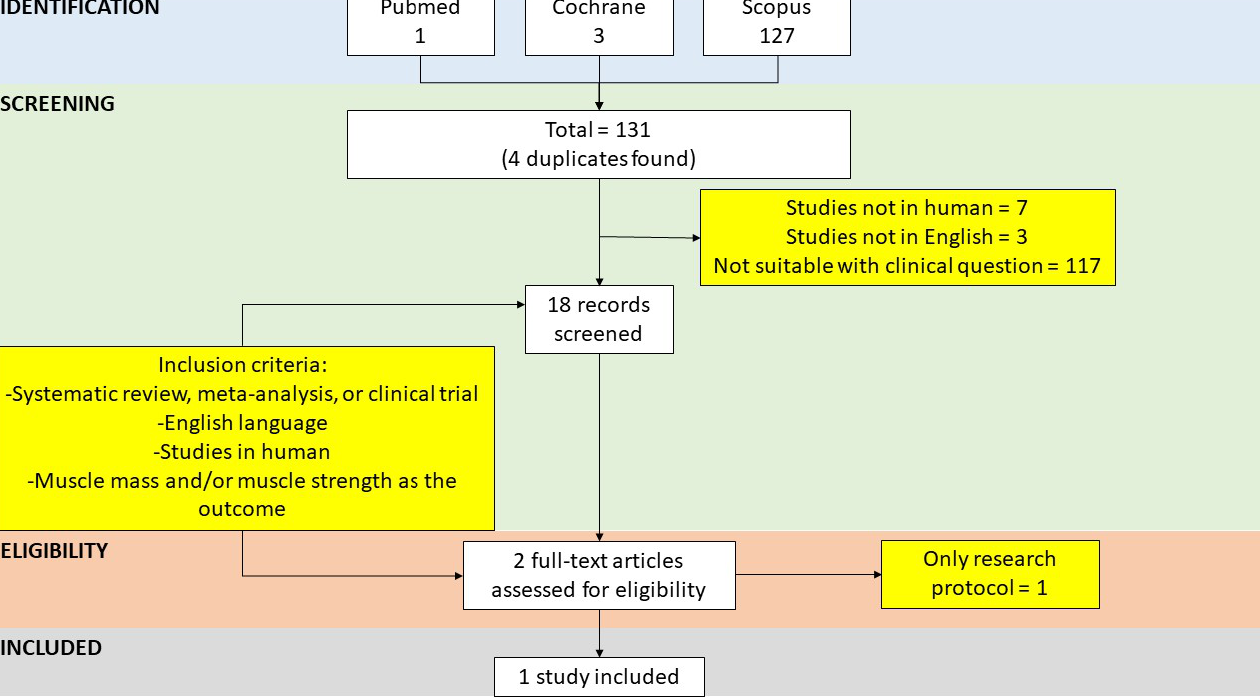
Figure 1. Flowchart of search